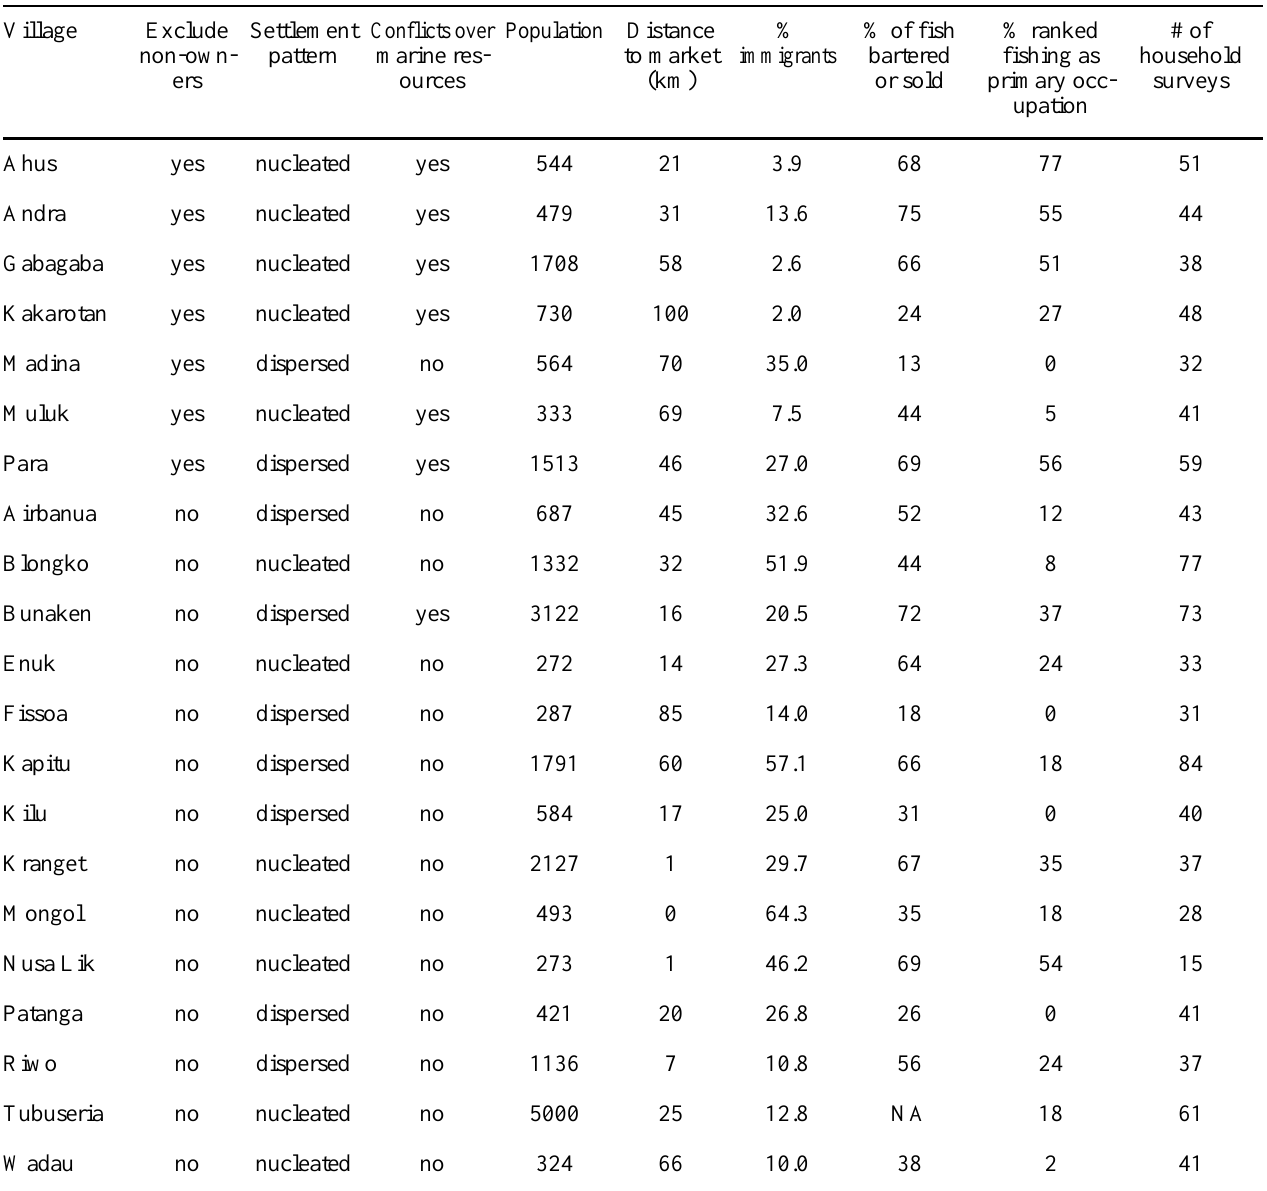
Table 1 . Summary of study